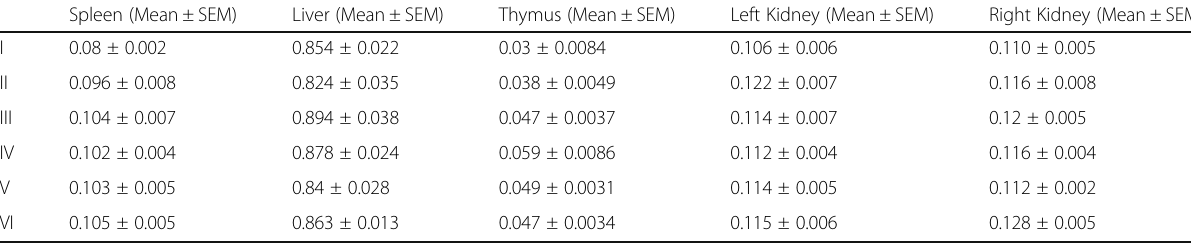
Table 2 The average weight of the organs collected from treated and non-treated mice Spleen (Mean ± SEM) Liver (Mean ± SEM) Thymus (Mean ± SEM) Left Kidney (Mean ±